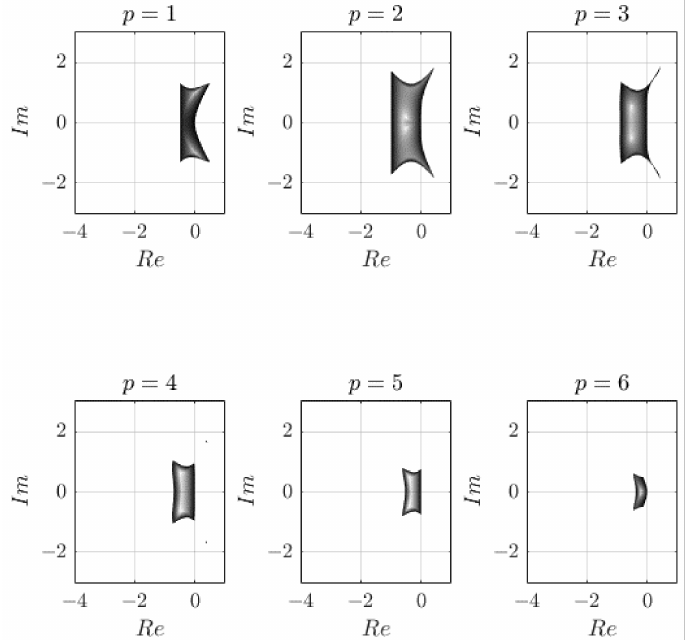
Figure 1. Stability regions of the semi-explicit Adams–Bashforth–Moulton methods with k =